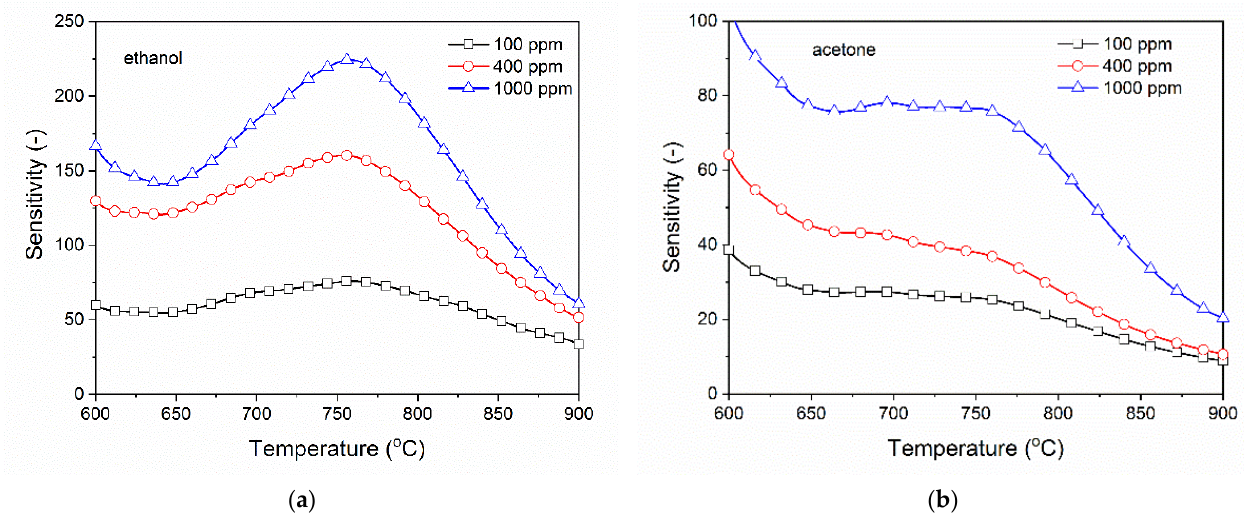
Figure 16. Sensitivity of β -Ga 2 O 3 nanowires to volatile organic compounds:( a ) The peak sensitivity to ethanol is at approximately 760 °C, ( b ) to acetone is at approximately 690 °C.